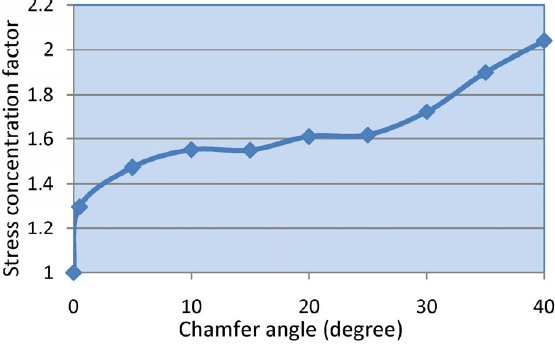
Fig. 9 Stress concentration vs. chamfer angle.